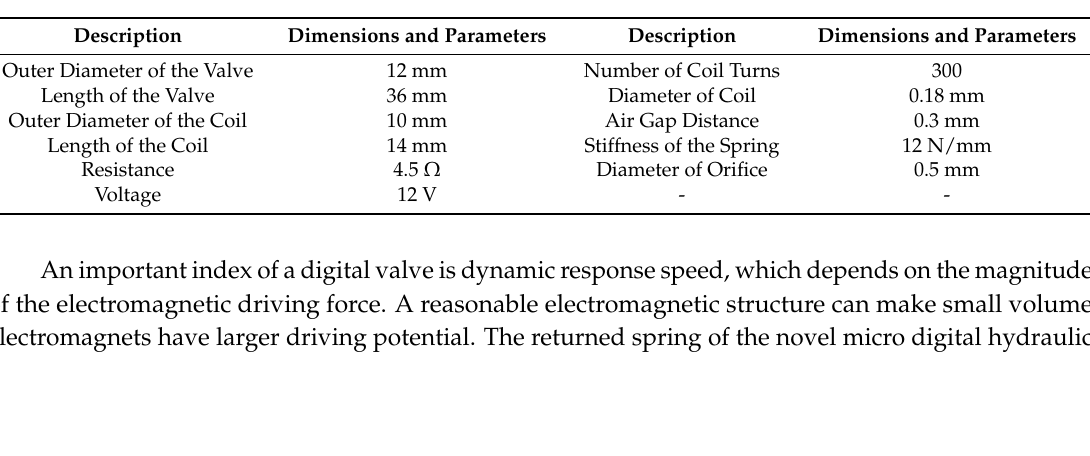
Table 2. Dimensions and parameters of the micro